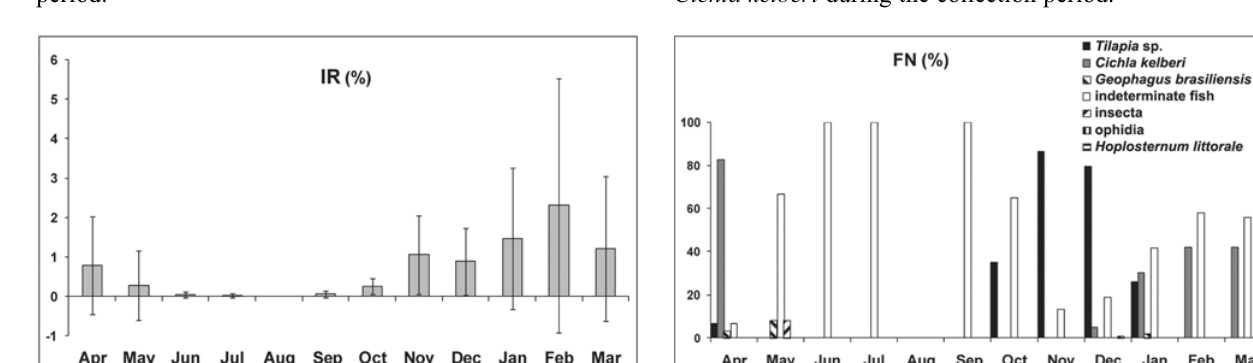
Fig. 1. Number of individuals caught during the collection period.